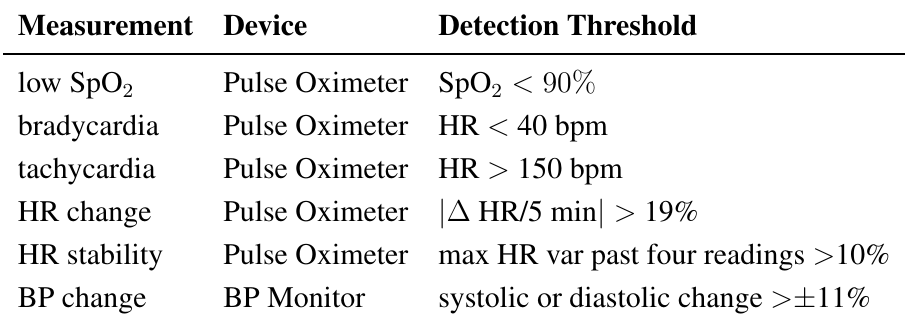
Table 1. Alert detection parameters and corresponding default thresholds. HR, heart rate; BP, blood pressure.